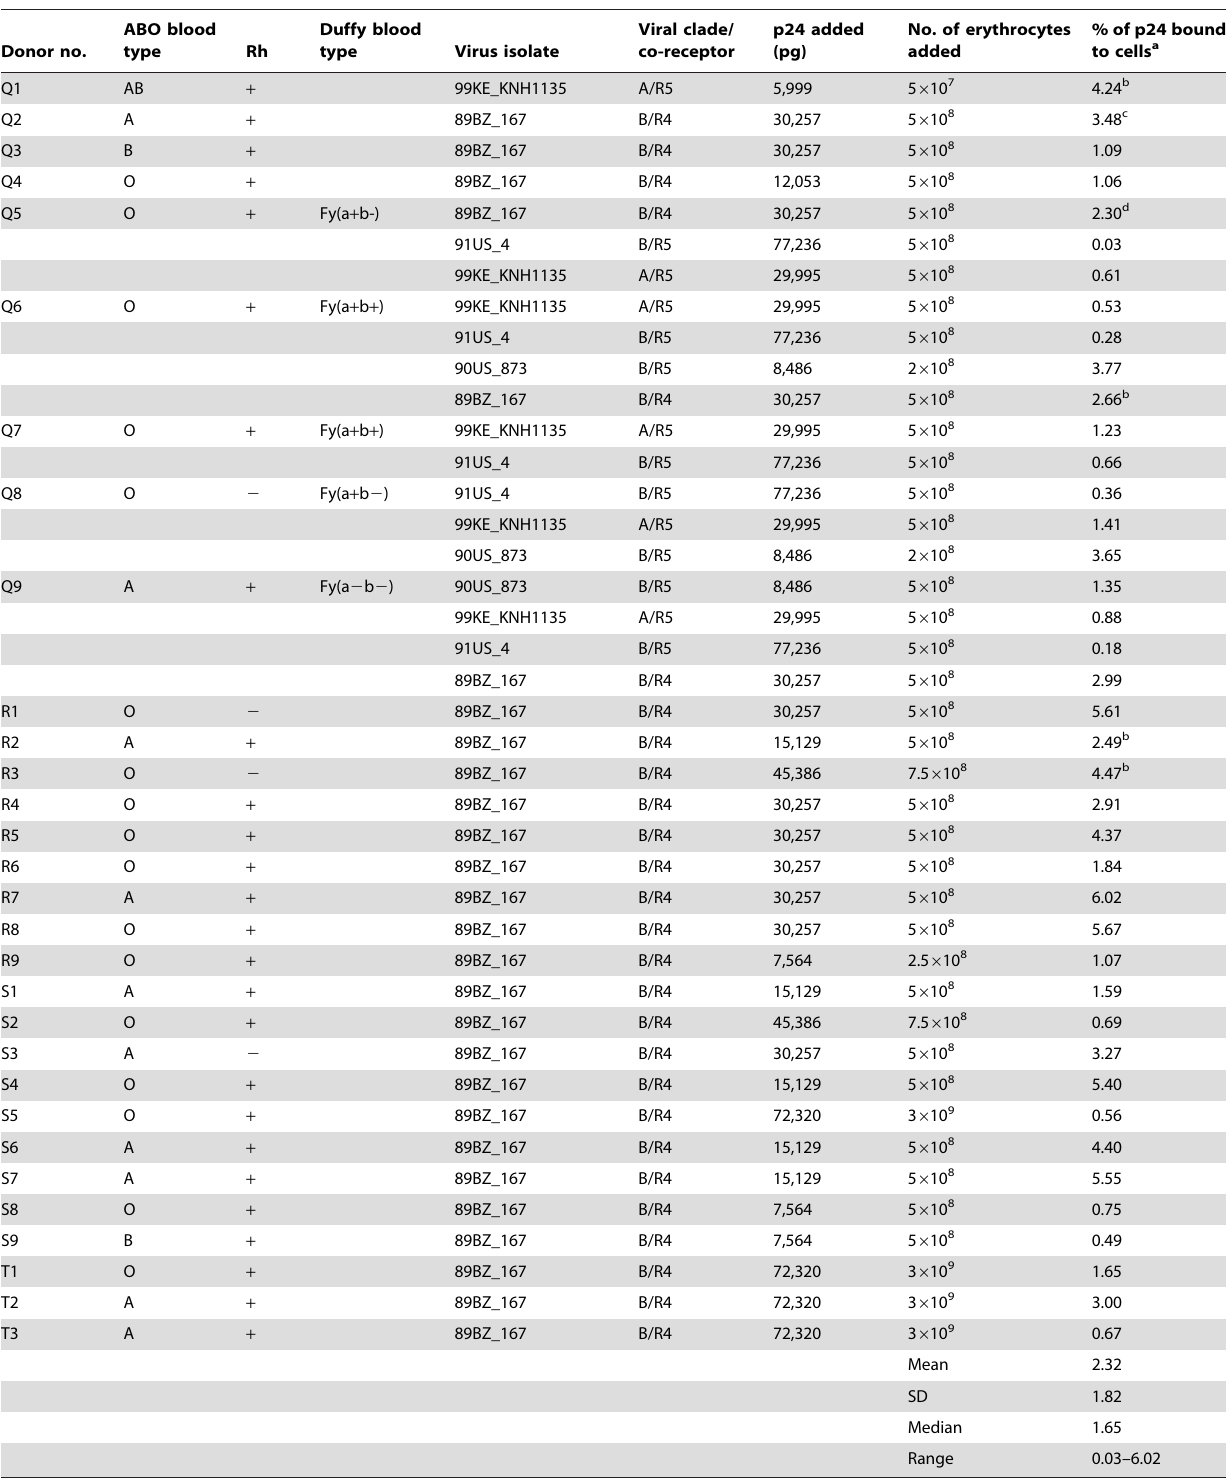
Table 1. Binding of four HIV-1 isolates to erythrocytes derived from 30 different donors.